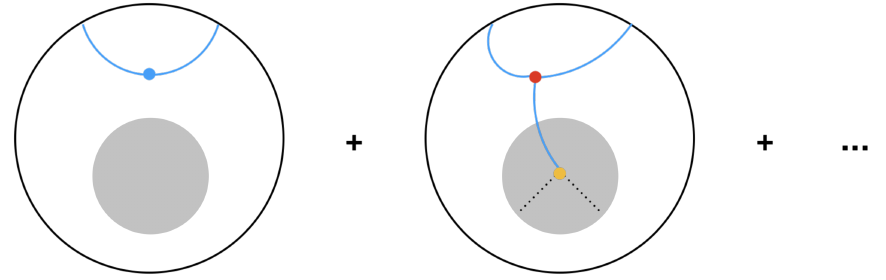
Figure 1 . Expansion in Witten diagrams of the 2-point function. The blue vertex represents the “trivial vertex” breaking in two the geodesic for the 2-point function. The red vertex corresponds to the cubic interaction λ ijk . The yellow vertex corresponds to the higher curvature coupling to W 2 . The shaded region is a cartoon representing presence of the black